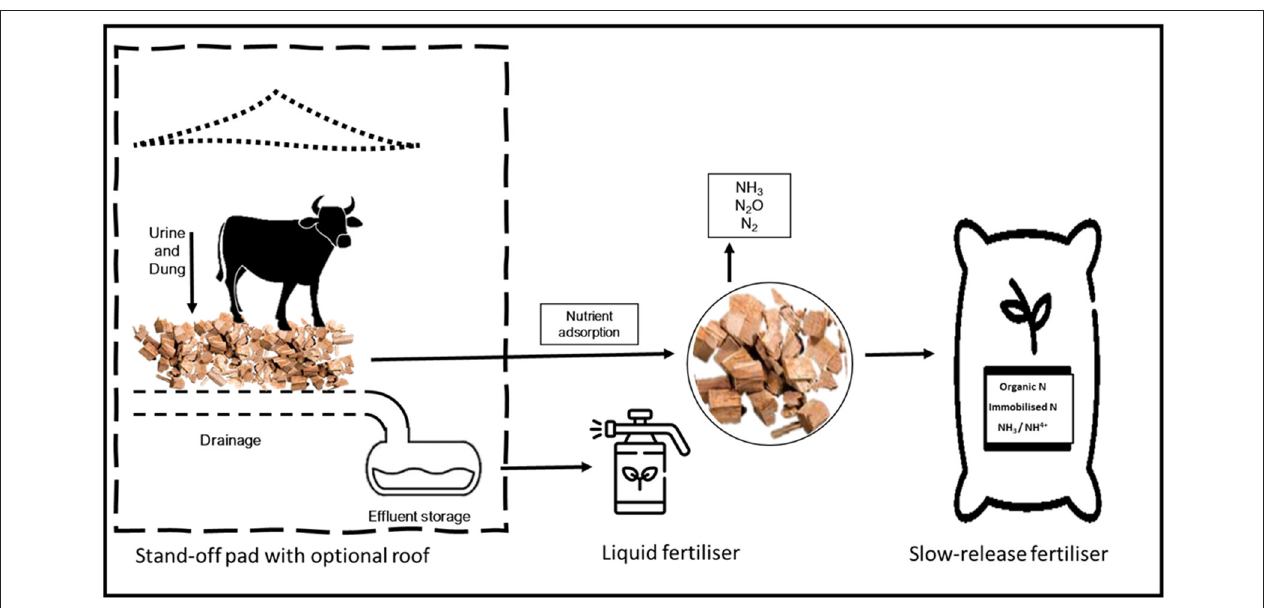
FIGURE 1 | Stand-off pad systems using wood waste bedding